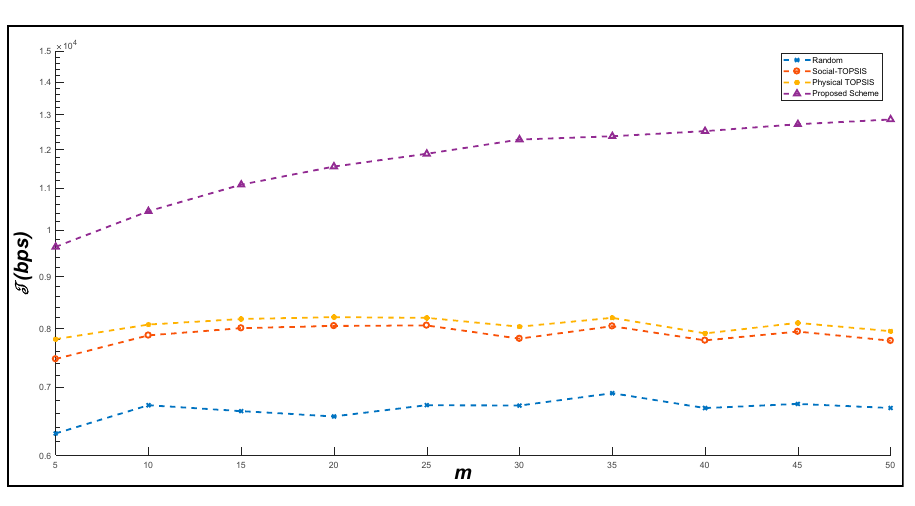
Figure 9. D2D throughput vs. m.